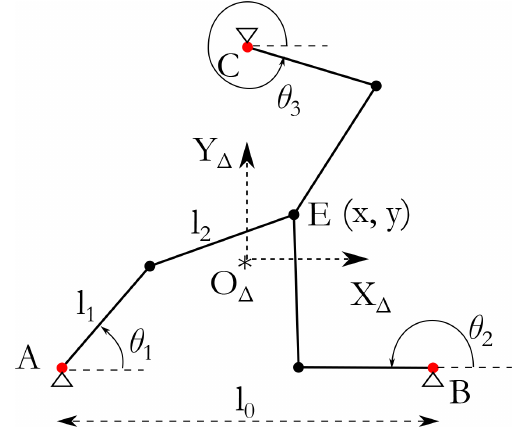
Figure 8. Geometric parameters of the 3-RRR redundant PPM.